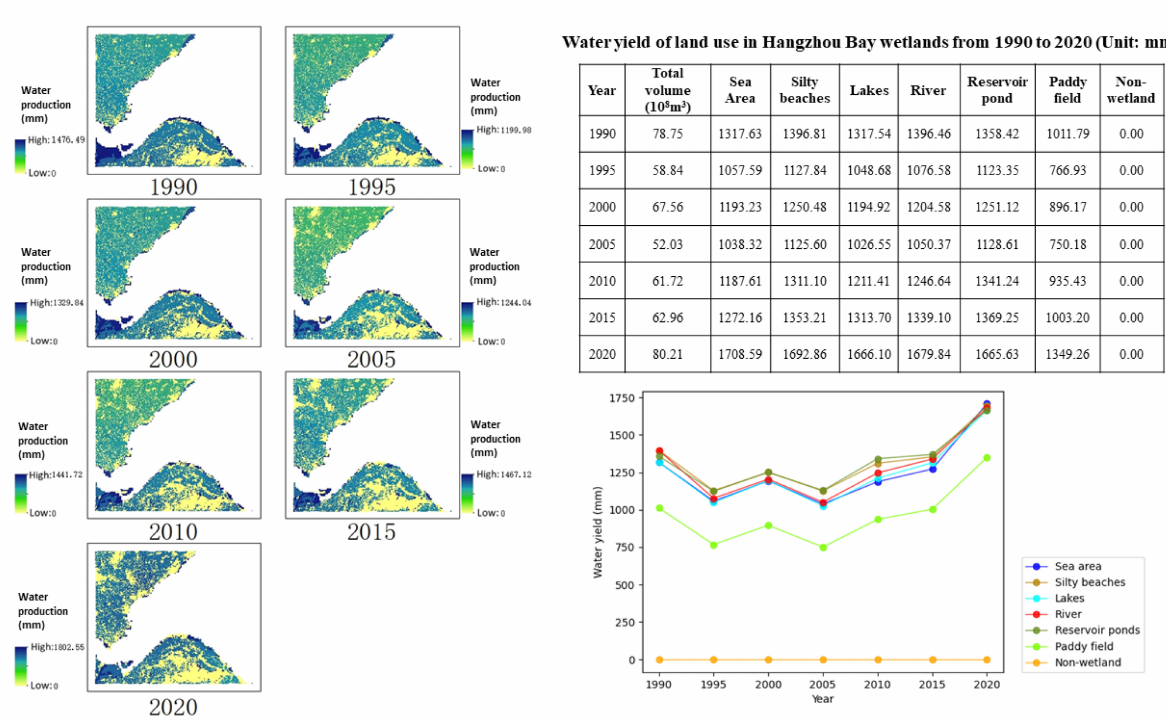
Figure 5. Distribution of water production of Hangzhou Bay wetlands from 1990 to